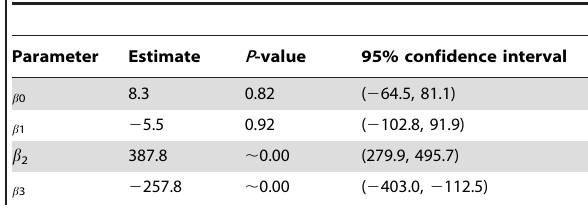
Table 3. Fitting the full regression model specified in equation (5) to the Ae. tauschii data.